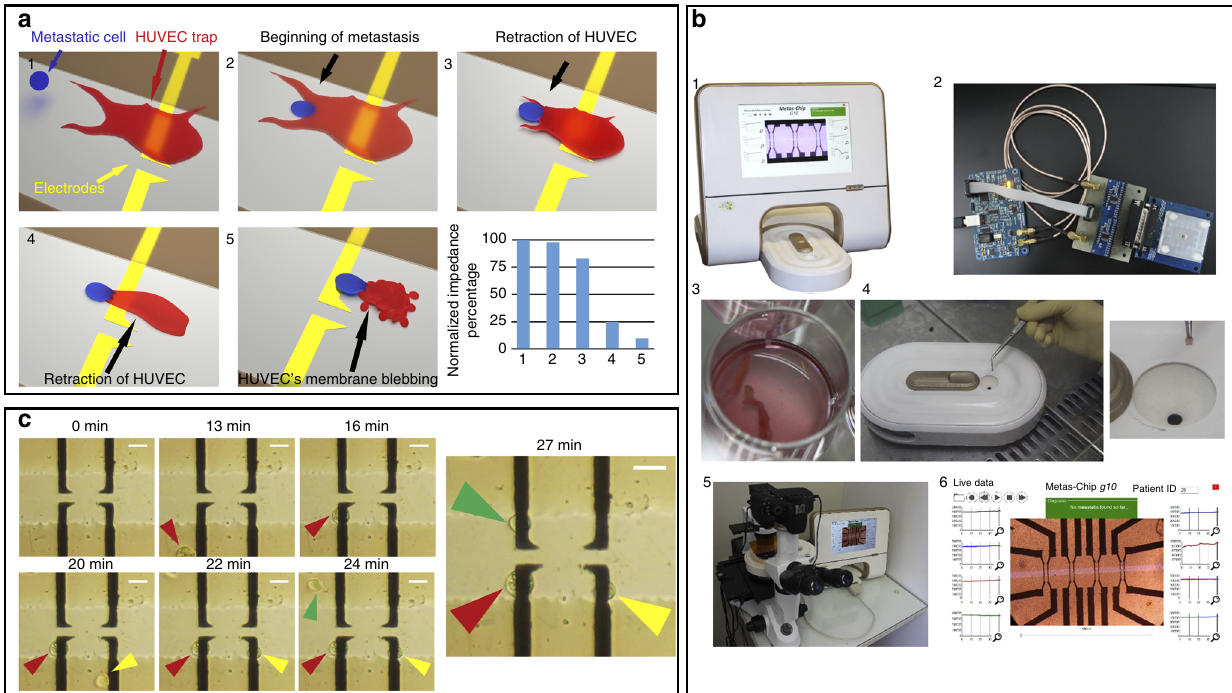
Fig. 1 Design and operation of the Metas-Chip. a The system captures and diagnoses metastatic cells from the unprocessed CNB or FNA sample derived from the lymph of any suspicious secondary tissue, based on their active interaction by single vascular traps and retraction of the trap due to invasion of metastatic cell. This sharply reduces the electrical resistance of the sensing region. b Image of a working Metas-Chip with complete accessories (b1) including multiple rows of microelectrodes selectively covered by single HUVECs that form consecutive traps for metastatic cells, electrical interfacial boards and matching optical-electrical measurements subsystem (b2); sentinel lymph sample of a patient (b3) is held on the inlet without any processing (b4). High-magni fi cation optical-capturing system takes live images from any interaction between single traps and probable detached cells from the sample (b5). b6 shows the software user interface (UI) of Metas-Chip, which include the microscopic image of sensing region with the micro-electrical traps collection networks in live matching by time-dependent electrical diagrams of all sensing traps. Occurrence of metastatic interaction would be recognized and presented by the system. The size of the main detecting chip is 0.5 × 0.5 cm 2 . c To prepare the chip for detection of metastasis, single HUVECs selectively covered each electrical trap by dielectrophoretic process (electrostatic driving force biased on the system). The scale bars are 25 µ m